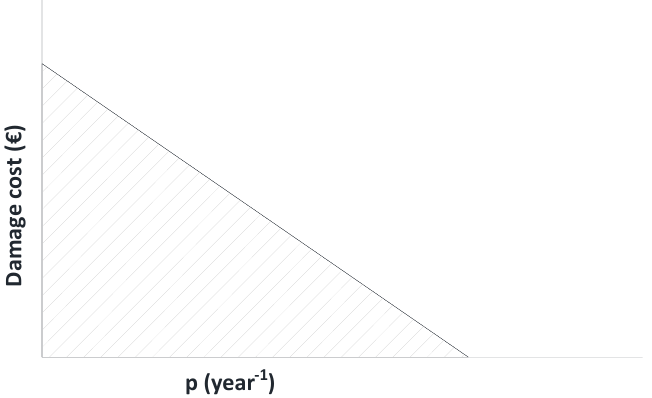
Figure 3. Annual cost of flood risk as the area under the curve in a log-linear relationship. The equation of the line obtained from this assumption takes the form of the expression shown in Equation (6), where a and b are the coefficients of the line.